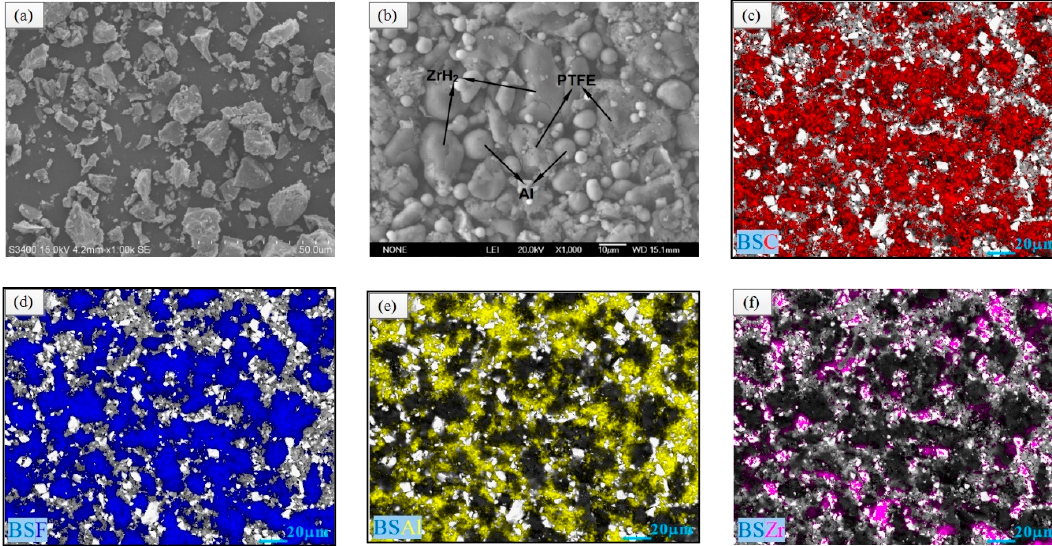
Figure 1. Internal microstructures and element distributions of the materials. ( a ) SEM (scanning electron microscope) image of ZrH 2 powder, ( b ) SEM image of mixture 2#, ( c ) C element, ( d ) F element, ( e ) Al element, and ( f ) Zr element.